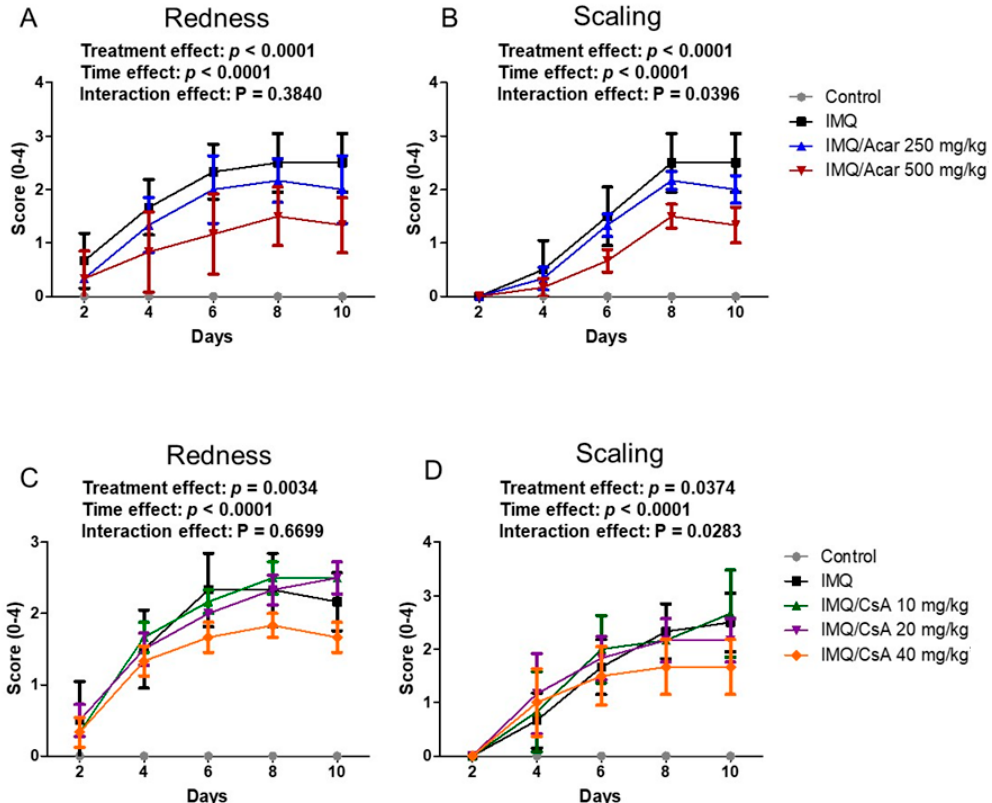
Figure 1. Effects of a single dose of Acarbose (Acar) (250 or 500 mg/kg) or Cyclosporin A (CsA) (10, 20, or 40 mg/kg) on skin lesions of mice with imiquimod (IMQ)-induced psoriasis-like dermatitis. The symptoms of redness ( A and C ) and scaling ( B and D ) were assessed. IMQ-treated mice and control mice received a daily dose of 62.5 mg of IMQ cream and control (vaseline) cream, respectively, on their shaved back skin for 9 days consecutively. Acar or CsA was administered to the mice orally once daily for 9 days consecutively by gavage in 200 μ L of water. Experimental data are expressed as mean ± SD ( n = 6). A mixed design two-way ANOVA was also applied to the supplementation effects within repeated time points.